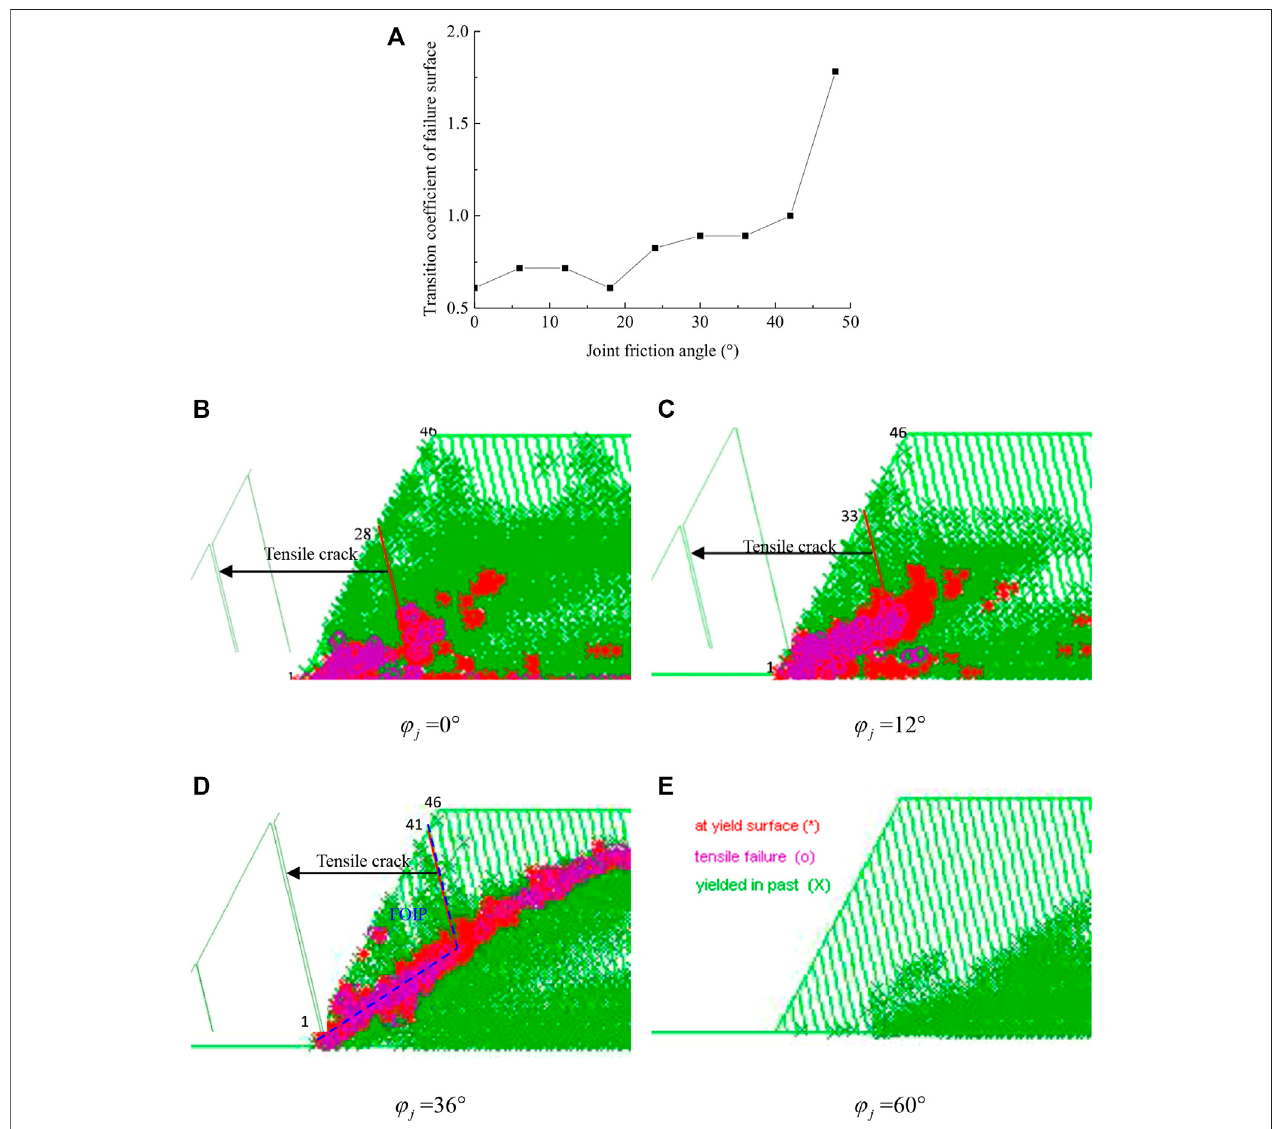
FIGURE 10 | Failure distribution of the slope for different joint friction angles ( φ j ). (A) : Relationship between the transition coef fi cient of failure surface and the joint friction angles; (B – E) : The simulated plastic zone for different joint friction angles.